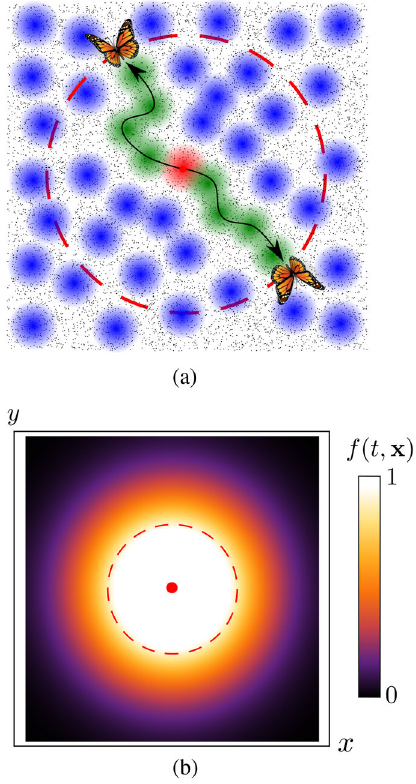
FIG. 1. (a) Snapshot at time t of the spread of chaos in an interacting diffusive metal. The fuzzy circles of radius ∝ ð Dt Þ 1 = 2 represent electrons diffusing through a background of impurities (small black dots). We make an analogy to the spread of an epidemic [31,44]: An “ infected ” electron inserted into the center of the figure at t ¼ 0 diffuses outwards (fuzzy red circle). As it encounters other diffusing electrons, it infects them. These newly infected electrons further infect other electrons and so on (fuzzy green circles). The flight paths of the butterflies track the spread of the infection. The radius of the region containing infected electrons (bounded by the dashed red circle) grows ballistically as v t . Although not shown in the figure, the electrons also have a B finite lifespan, given by the inverse of the quasiparticle decay rate. This needs to be taken into account when considering the population of infected electrons as a function of time. The function f ð t; x Þ is roughly equivalent to the local fraction of infected electrons at a point x . (b) The behavior of f ð t; x Þ for one operator placed at the center of the figure (red dot) and the other at a position x shown as a function of x at a given time t . Note that f ð t; x Þ displays a light cone (a time slice of which is bounded by the dashed red circle; this region exclusively contains infected particles) within which it has saturated and no longer grows. The t radius of this region grows as v B